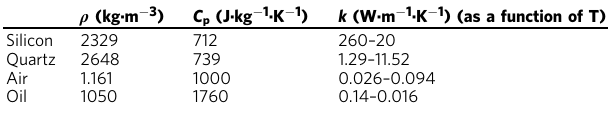
Table 1 Material properties for thermal